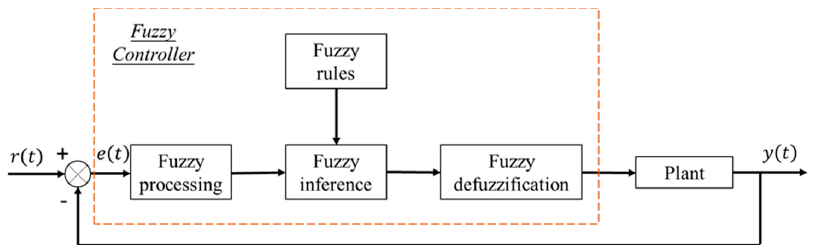
Figure 2. Block diagram of the fuzzy control theory. J. Mar. Sci. Eng. 2019 , 7 , x FOR PEER REVIEW